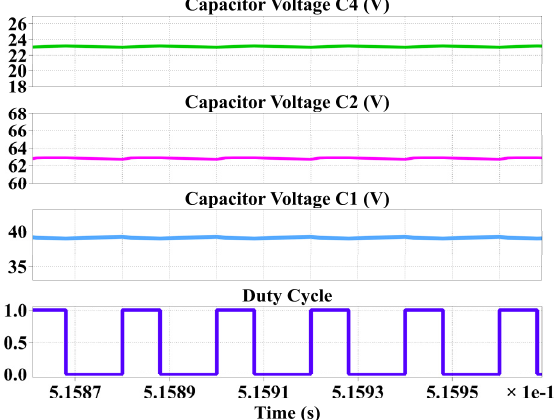
Electronics 2020 , 9 , x FOR PEER REVIEW 11 of 19 = 0.4. Figure 10. Capacitor voltages of C 1 , C 2 , and C 4 at D = 0.4. Figure 10. Capacitor voltages of C 1 , C 2 , and C 4 at D Figure 10. Capacitor voltages of C 1 , C 2 , and C 4 at D = 0.4.